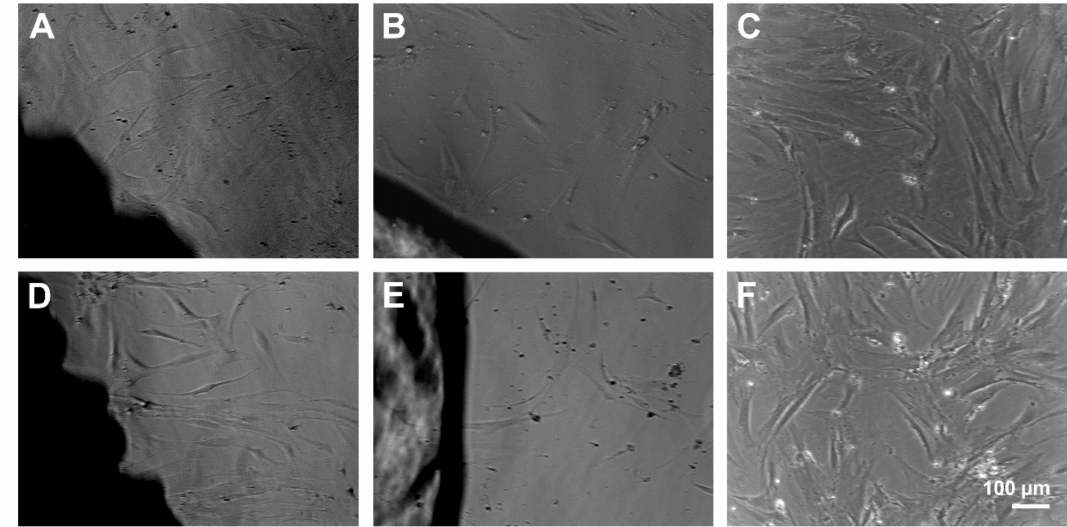
Figure 3. MSC growing at the surface of porous scaffolds ( A , D ) and compact scaffolds ( B , E ) for 3 ( A – C ) and 6 days ( D – F ). Scale bar of F is representative for ( A – E ).